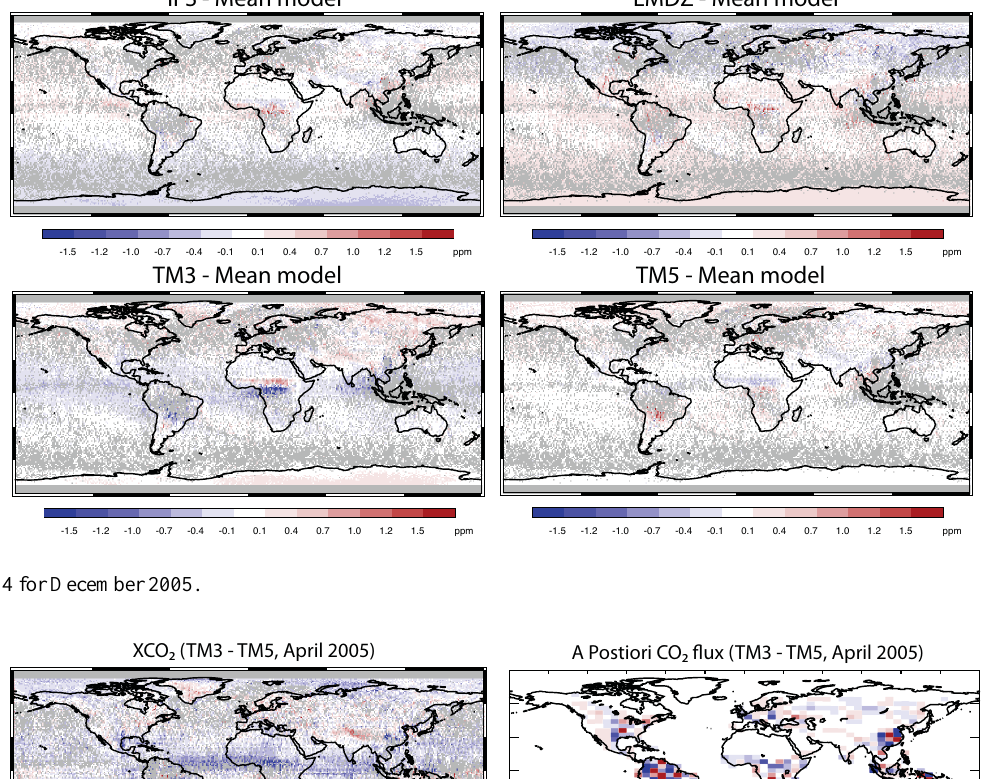
Fig. 5. As Fig. 4 for December 2005.